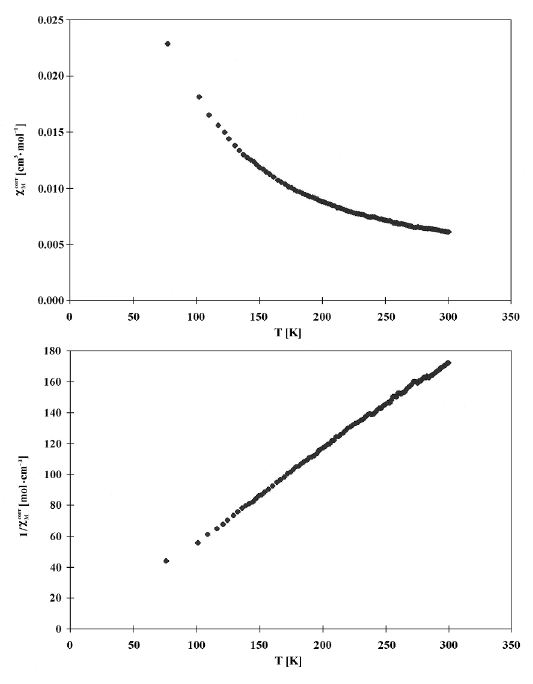
Figure 5. Temperature dependencies of corrected molar susceptibility (top) and reciprocal susceptibility (bottom) for 1